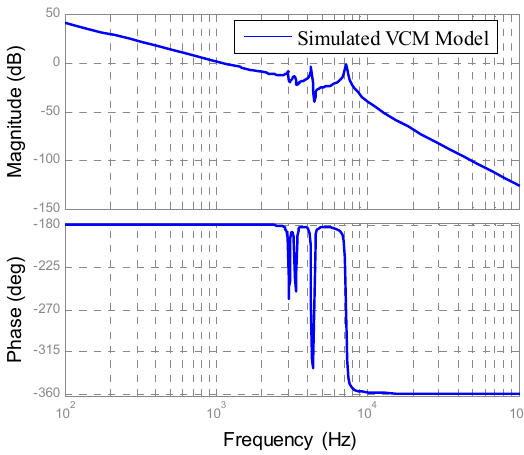
Figure 4 . The frequency response of the voice coil motor (VCM) model .